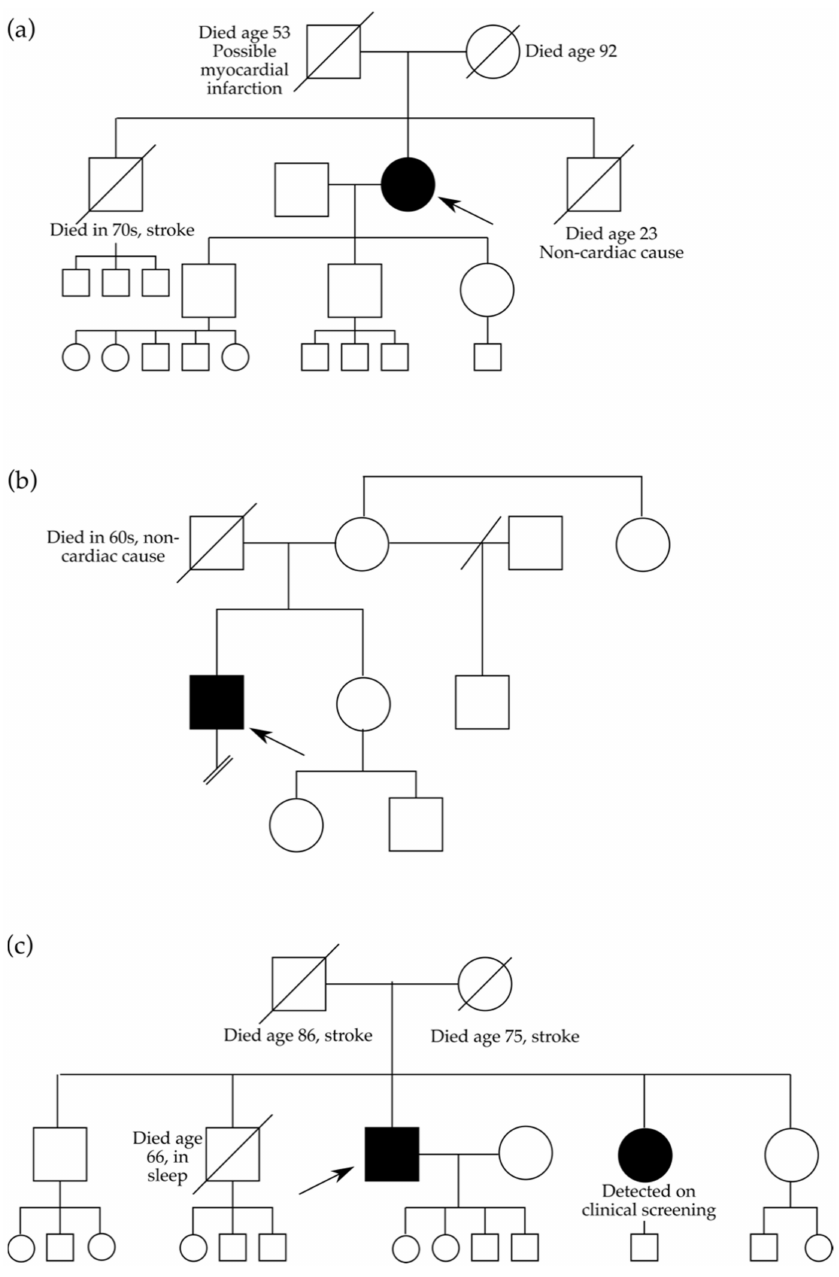
Figure 2. Family pedigrees for the three probands with HCM presented in this study. Pedigrees for ( a ) family 1, ( b ) family 2, and ( c ) family 3. Arrow indicates the probands subject to genetic testing in this study. Filled shapes indicate clinically affected